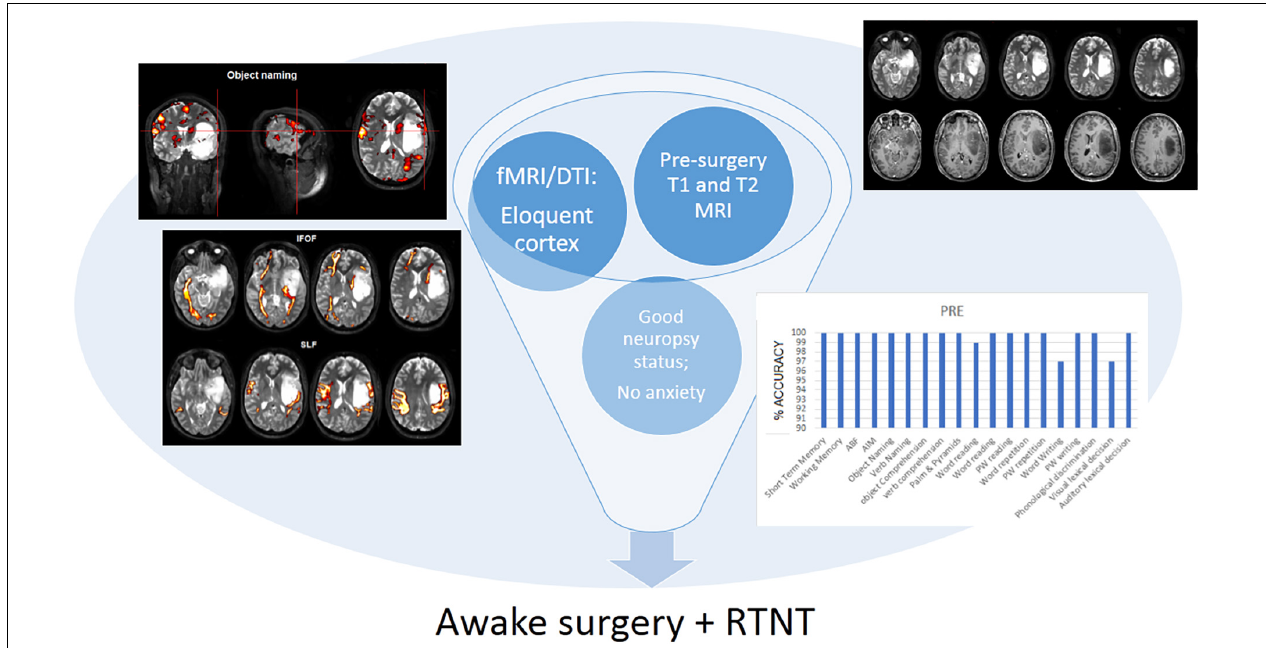
FIGURE 1 | Decision tree for awake surgery plus RTNT procedure. In the case presented here, we found that the patient—male, young (25 year old), right-handed—had a low-grade glioma involving the temporo-insular cortex. The fMRI and DTI examination indicate that the brain tumor is infiltrating the functional tissue. The neuropsychological assessment showed that the cognitive performance of the patient is within the normal range on the majority of the tests administered, and provided the patient is not feeling particularly anxious/depressed, awake surgery plus RTNT were